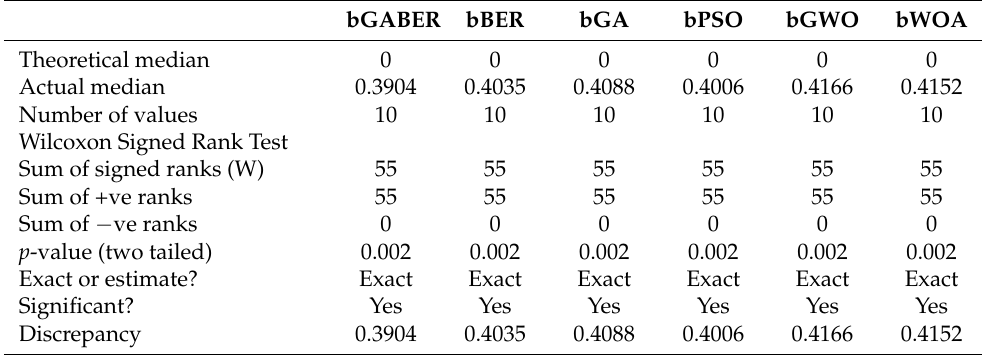
Table 14. Wilcoxon test of the results achieved by the proposed feature selection method when applied to the solar radiation dataset.